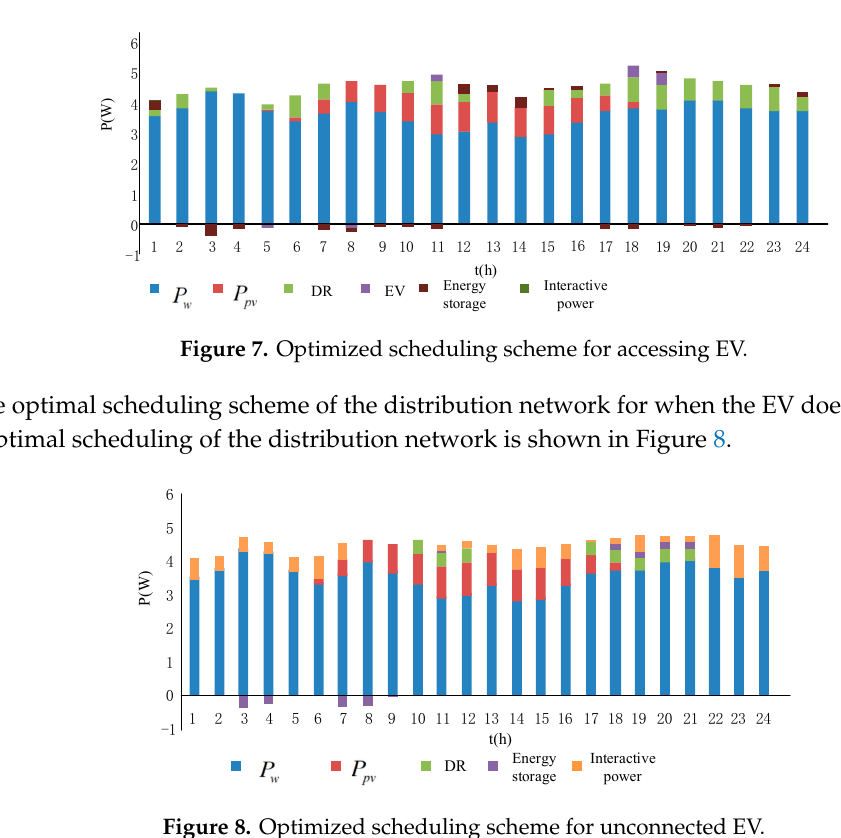
Table 4. Demand response (DR) resource parameter.